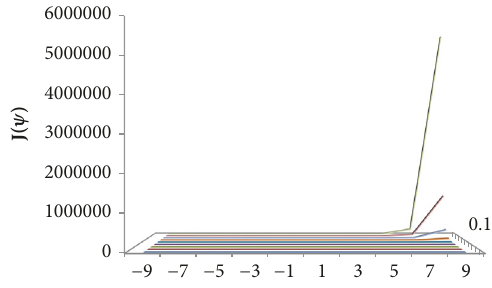
Figure 1: Graph of expected present value of the utility of asset 𝐽(𝜓) versus control 𝜓 and degree of relative risk 𝜆 while subjective discount rate 𝜂 is fixed at 0.1 .